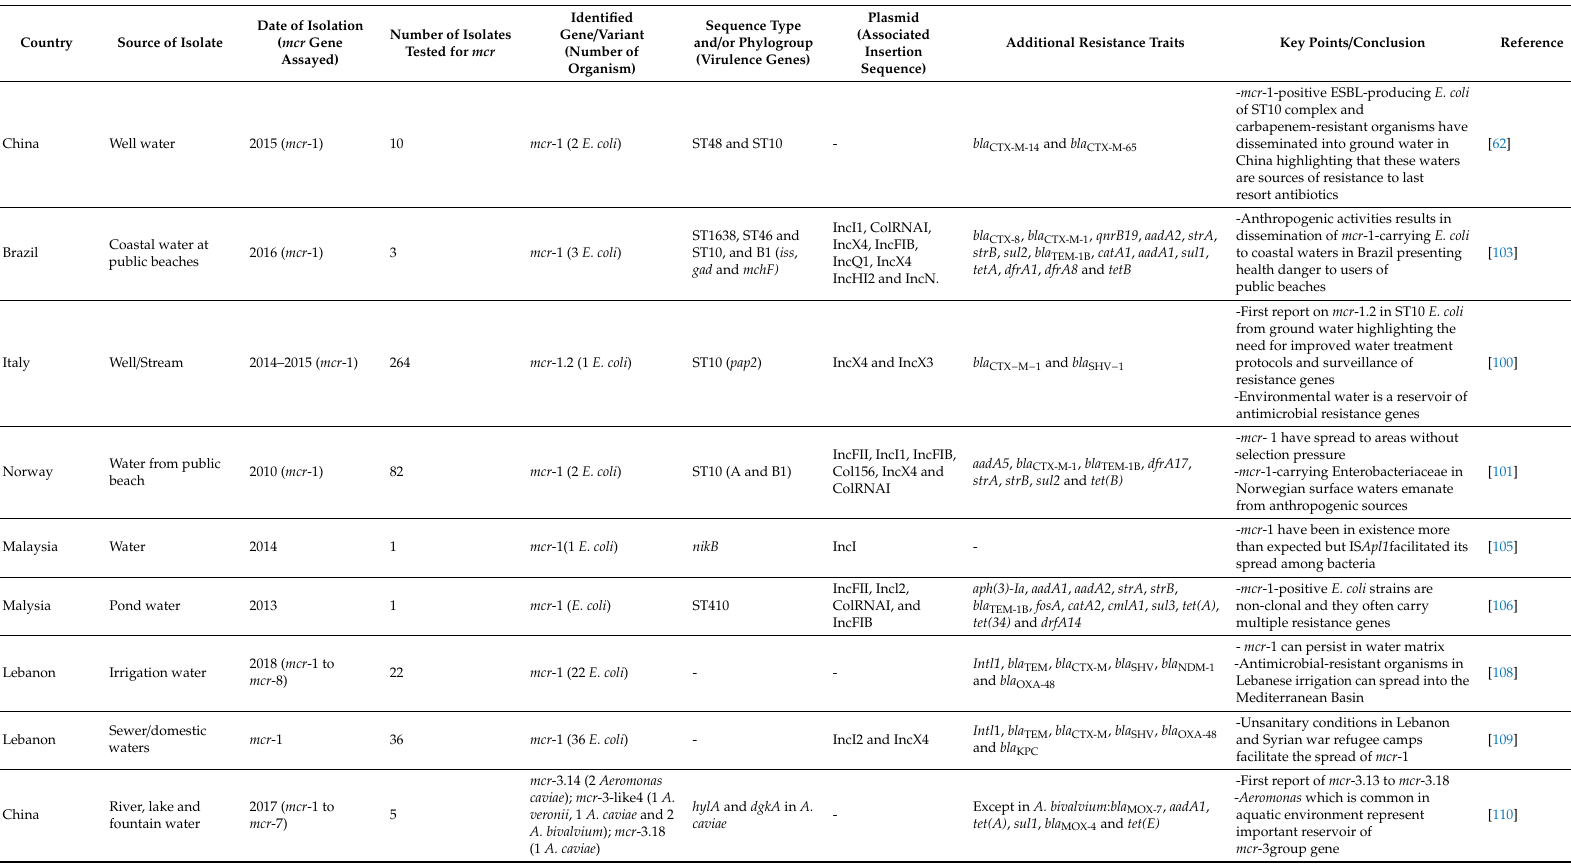
Table 3. Studies reporting plasmid-mediated colistin resistance in isolates from fresh and seawaters. Country AdditionalResistanceTraits KeyPoints / Conclusion